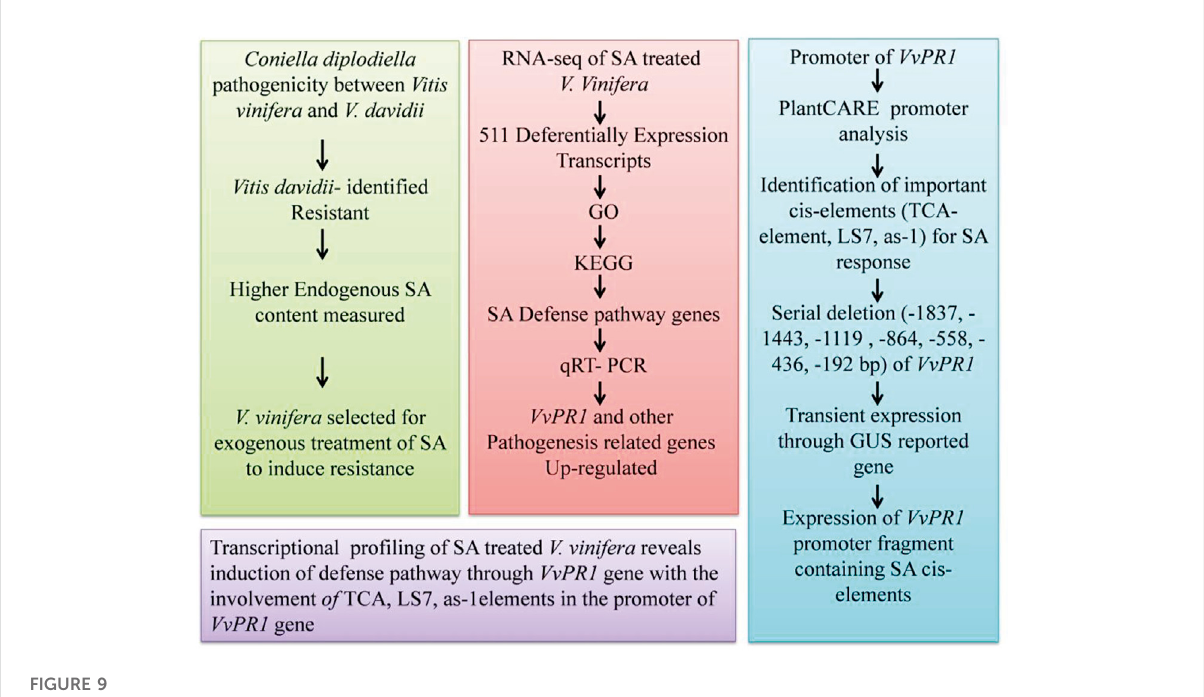
FIGURE 9 Flow chart of study pattern showing the different steps of inducing the pathogenicity of grape white rot, the RNA-seq data analysis, promoter analysis through serial deletion of promoter, and the